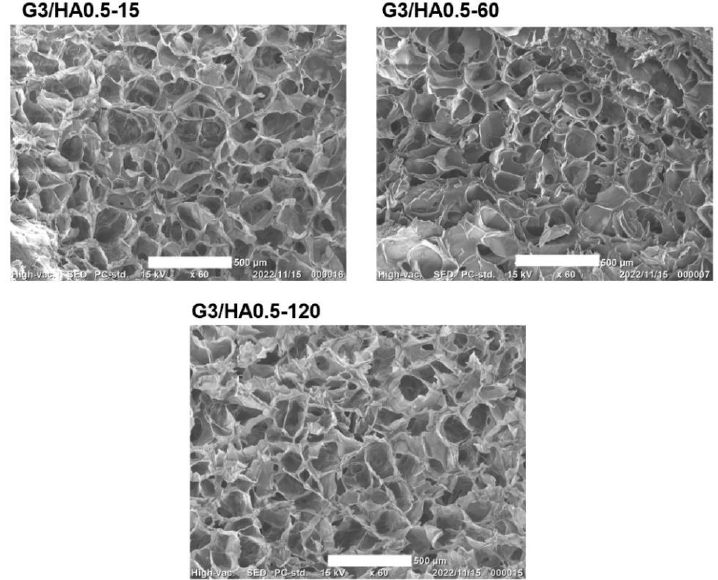
Figure 5. Scanning electron microscope observation of the cross-section of freeze-dried specimens of Gelatin-Ph/HA-Ph hydrogel obtained through 15–120 min H 2 O 2 exposure time. Scale bar: 500 μm.